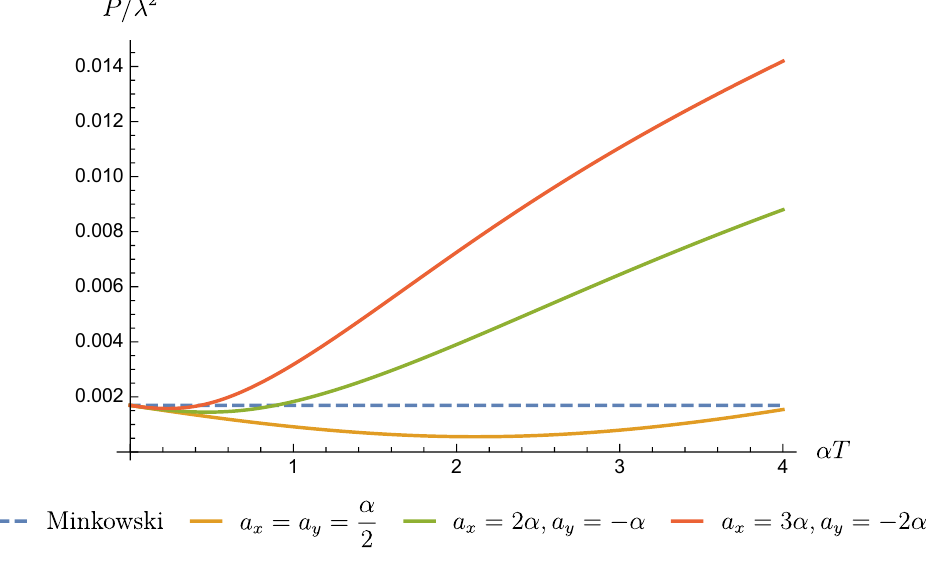
Figure 2 . Excitation probability of a single detector. We display the detector transition probability for three shockwave profiles with the same energy density α : a x = 2 α, a y = − α (red curve), a x = 3 α, a y = − 2 α (green curve), a x = a y = α (orange curve) and we compare them to 2 the Minkowski response (dashed blue curve). The scenario follows Left figure 1: the detector is located at the origin, with the switching peak at t = 0 , and energy gap Ω T = 2 , the shockwave is localized at u = 0 . Note that, in this parametrization, when α = 0 , f ( ~x ) = 0 identically and we recover Minkowski